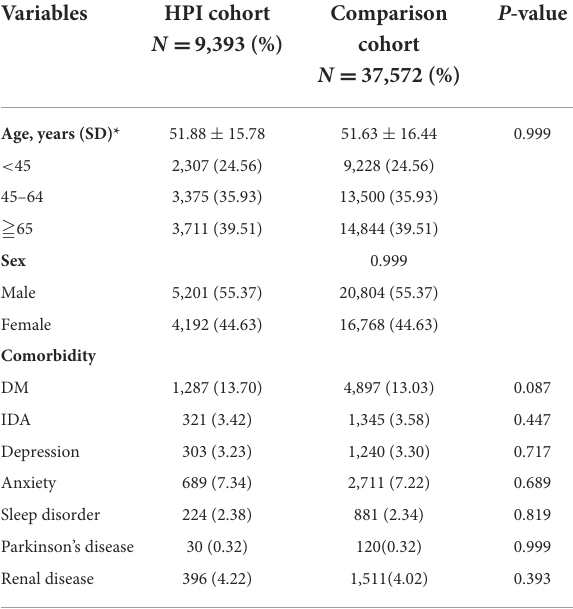
TABLE 1 Baseline demographic status and comorbidity compared between HPI and comparison